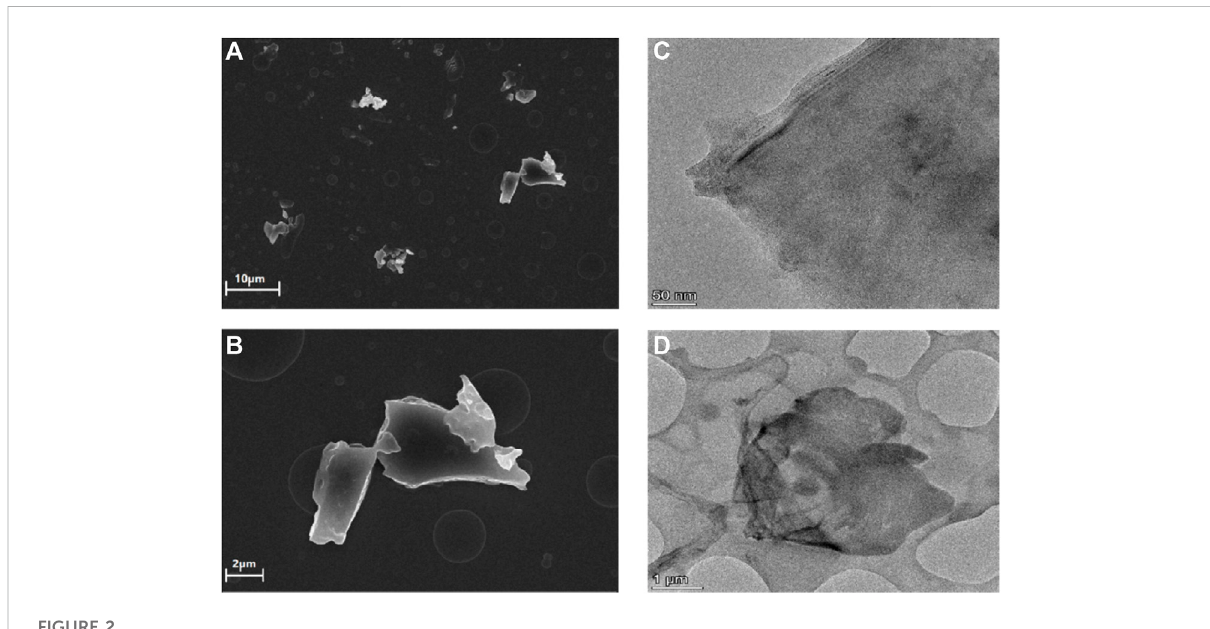
FIGURE 2 SEM (A,B) and TEM images (C,D) of